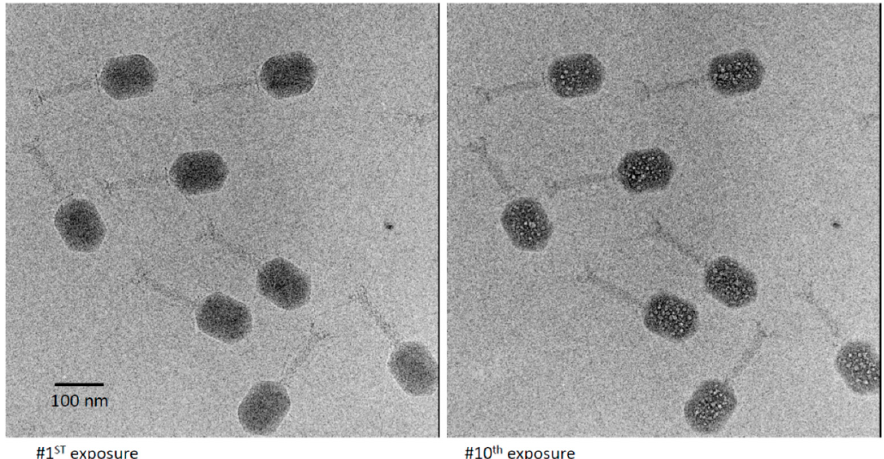
Figure 3. First and 10th exposures from a dose series of cryo-electron micrographs of a field of T4 virions. In the 10th exposure, multiple bubbles are seen in each virion, which are randomly distributed except for exclusion from a peripheral zone about 110 Å thick.